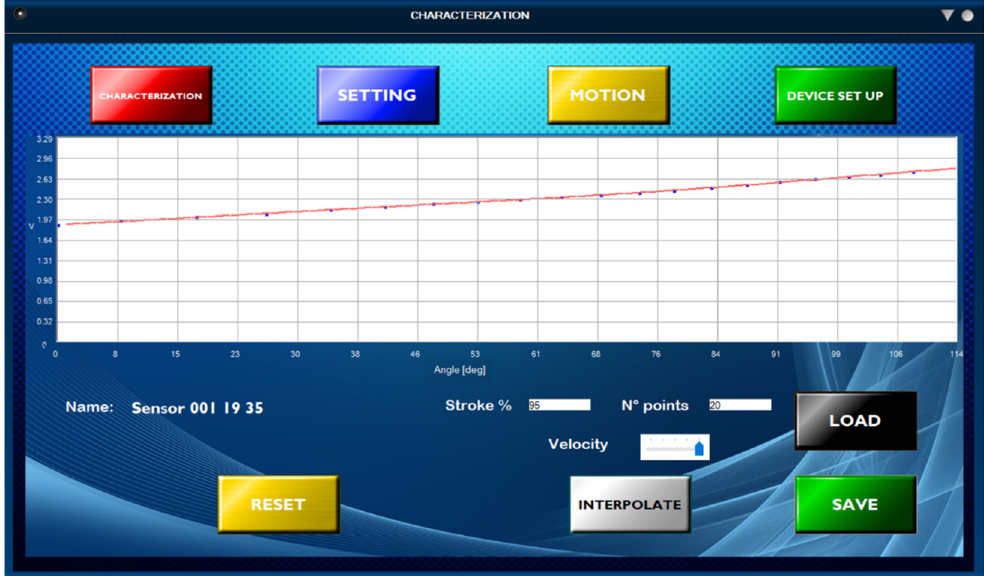
Figure 13. GUI of the software for the test bench management.